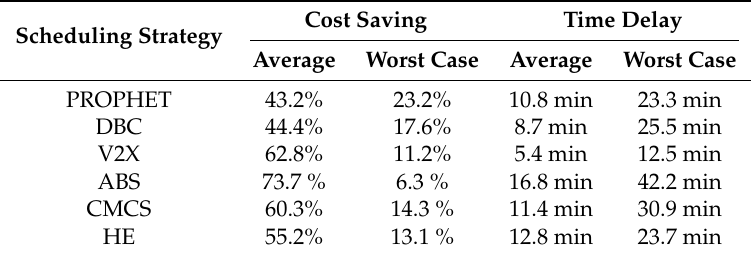
Table 3. Relative cost and time delay